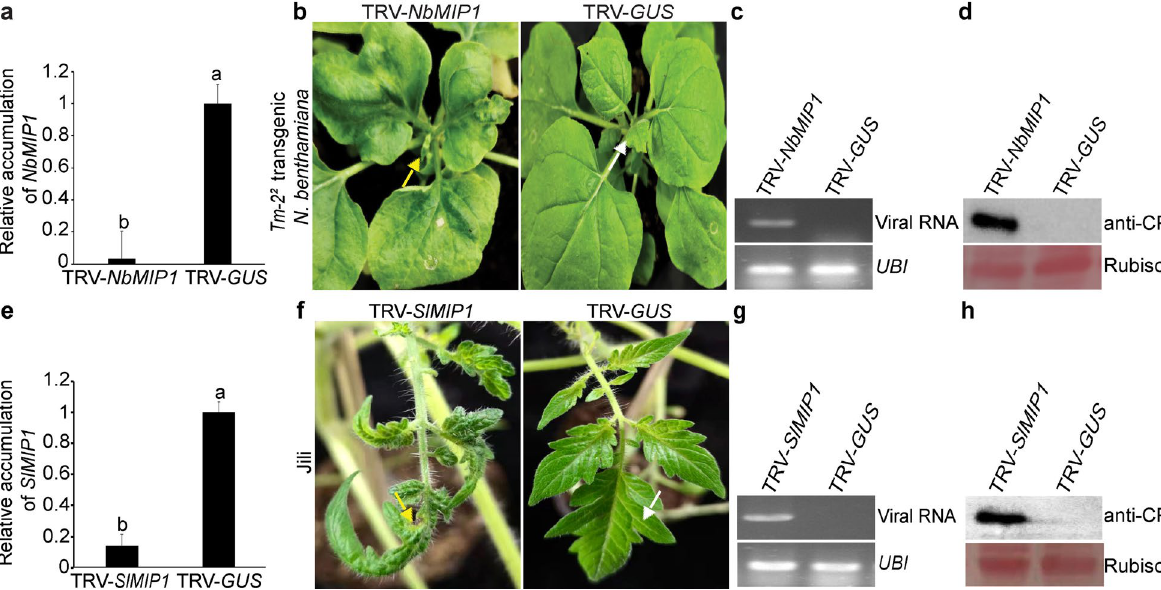
Fig. 5 Effect of MIP1 on the Tm-2 2 ‑mediated disease resistance against ToMMV. a RT‑qPCR analysis of the NbMIP1 mRNA accumulation levels in the silenced and the control Tm-2 2 transgenic Nicotiana benthamiana plants inoculated with TRV‑derived vector at 10 days post‑agro‑infiltration (dpai). b The symptoms of the control and NbMIP1- silenced Tm-2 2 transgenic N. benthamiana plant inoculated with ToMMV at 7 dpai. c, d RT‑PCR detection of the ToMMV RNA accumulation ( c ) and Western blot analysis of ToMMV CP accumulation ( d ) in the systemic leaves of NbMIP1 ‑silenced and the control Tm-2 2 transgenic N. benthamiana plant . e Silencing efficiency of SlMIP1 gene in Jili tomato plants analyzed by RT‑qPCR at 10 dpai. f The symptoms of SlMIP1- silenced Jili tomato and the control plants inoculated with ToMMV at 14 dpai. g RT‑PCR detection of ToMMV RNA in the systemic leaves of SLMIP1 ‑silenced and control Jili tomato plants inoculated with ToMMV at 14 dpai. h Western blot analysis of ToMMV coat protein (CP) in systemic leaves of the SlMIP1- silenced and the control plants at 14 dpai. The UBI gene served as an internal control for the RT‑PCR and RT‑qPCR analysis. The values indicate the mean SD of three biological replicates. Letters indicate the significant differences in MIP1 accumulation + between the MIP1- silenced and the control plants ( t ‑test, P < 0.05). Yellow arrows show symptomatic systemic leaves and white arrows show asymptomatic systemic